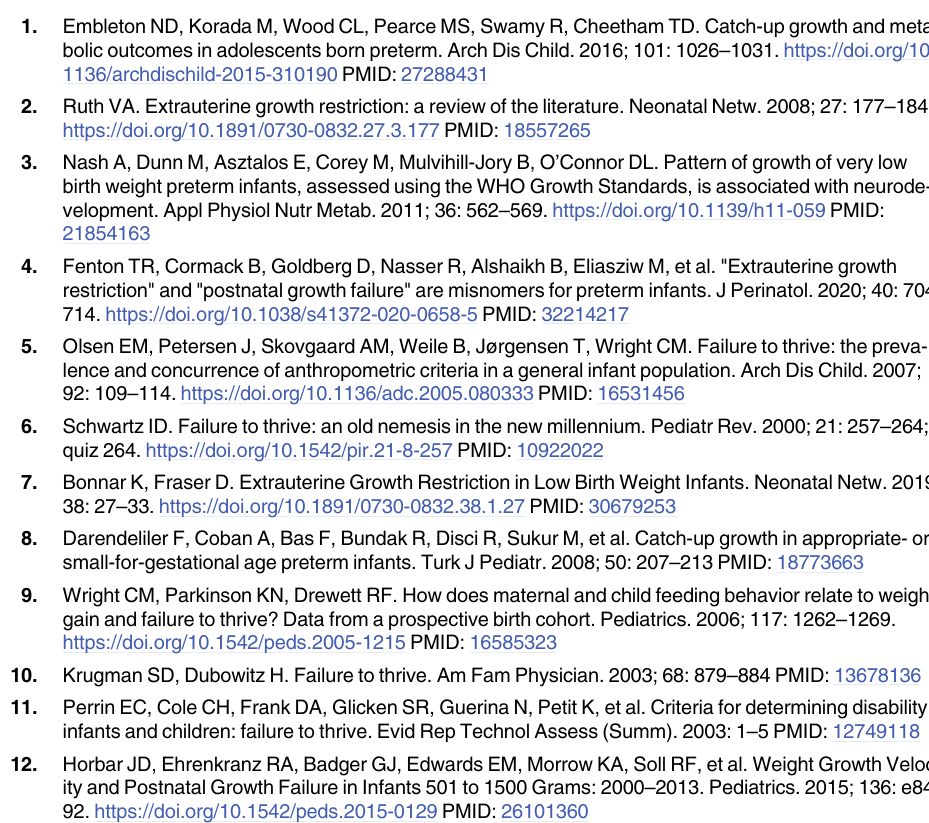
S1 Table. Comparison of clinical characteristics between follow up group and non-follow up group at follow-up